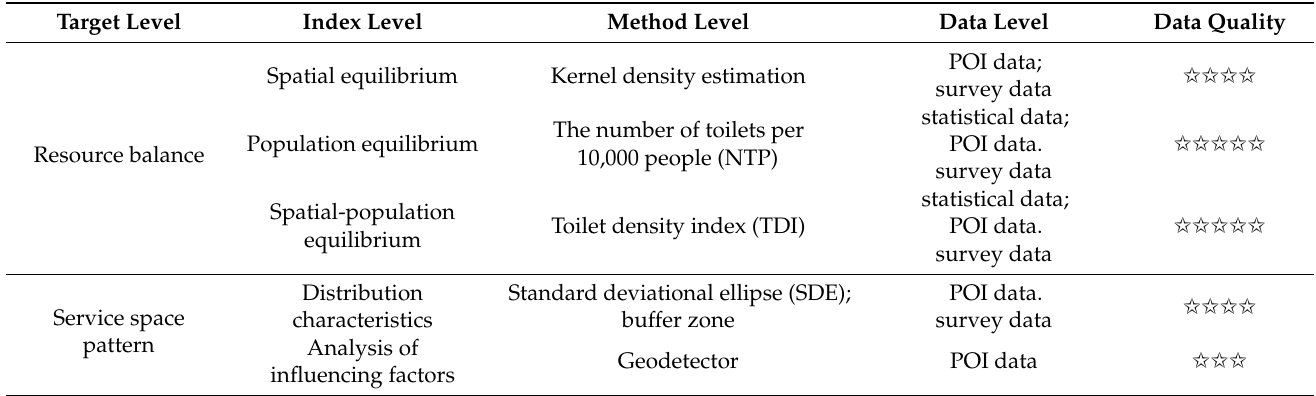
Table 1. Evaluation system of service capacity of urban public toilet